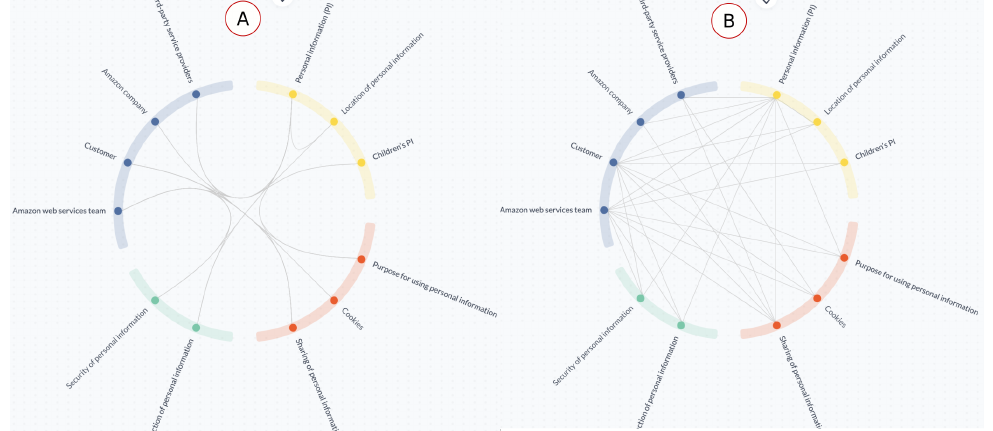
Figure 7. Using edge bundling technique ( A ) to reduce edge crossing ( B ).